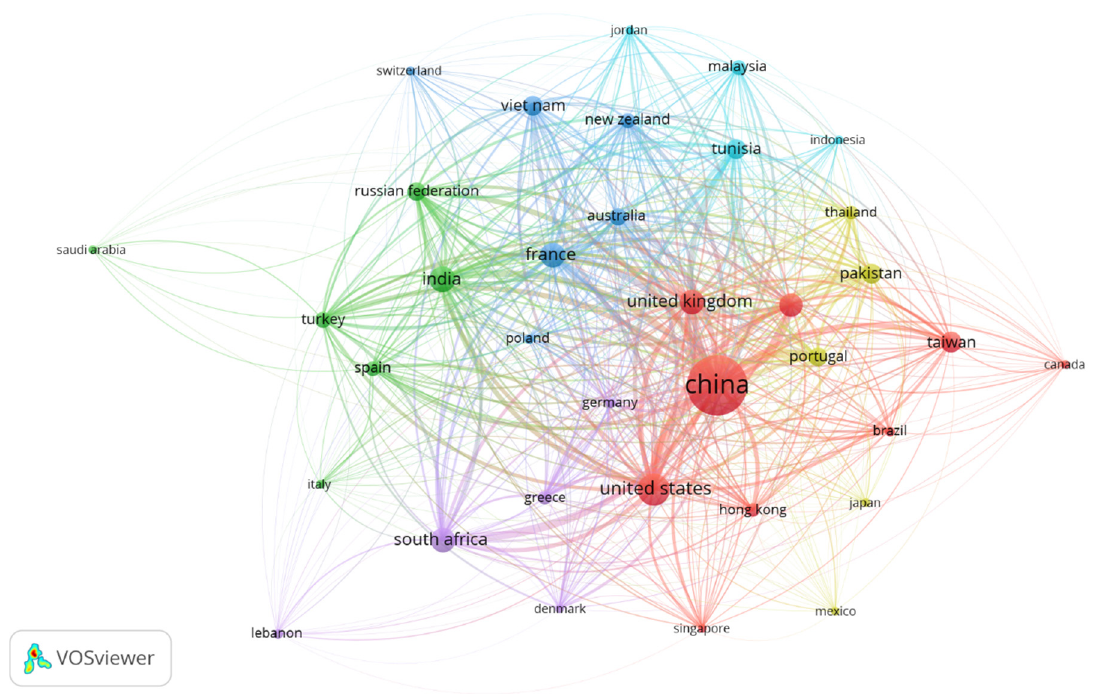
Figure 3. Mapping based on authors from different countries.